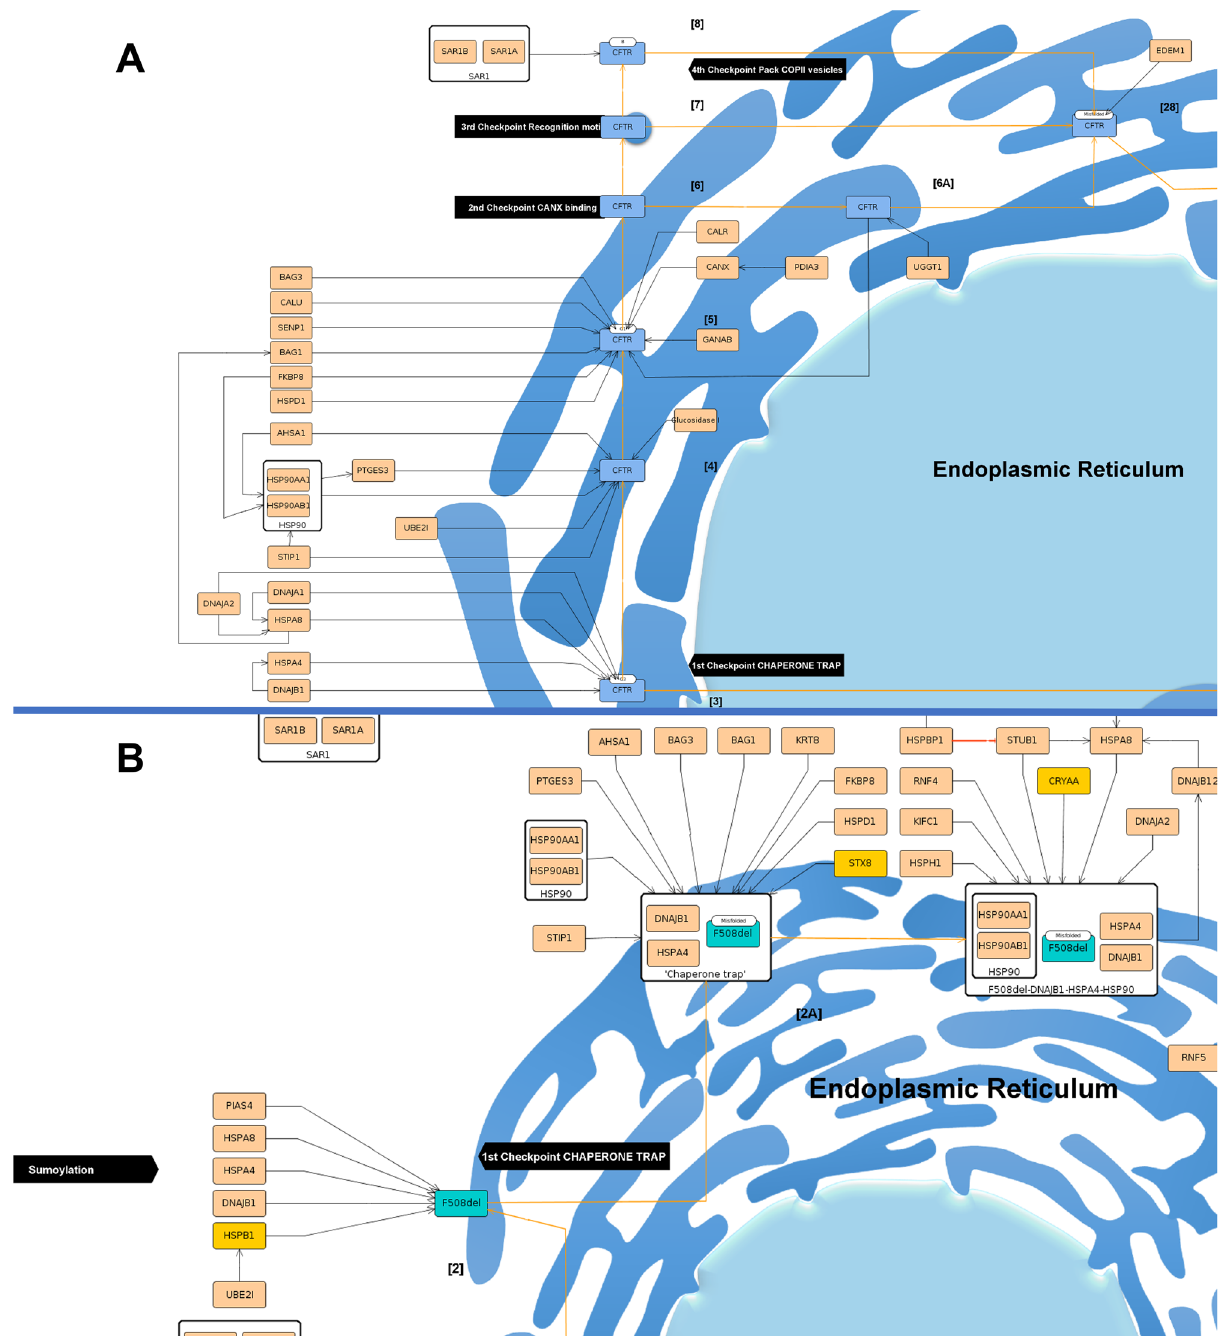
Figure 3. Representation of folding at ER. Wt- CFTR ( A ) and F508del- CFTR ( B ) are subjected to the sequential ERQC checkpoints, indicated in black. On the wt- CFTR is possible to see the four checkpoints of the CFTR protein (in blue). In the case of F508del- CFTR is possible to see a bifurcation in the pathway, where it can be targeted to degradation or rescued, where it appears red at the cytosol. It is also indicated the beginning of the sumoylation degradation pathway. The proteins are represented in beige with the orange lines indicating the movement of the protein and the black lines indicating stimulation. The white boxes containing several proteins indicate a complex. Unique interactors to F508del- CFTR are represented in